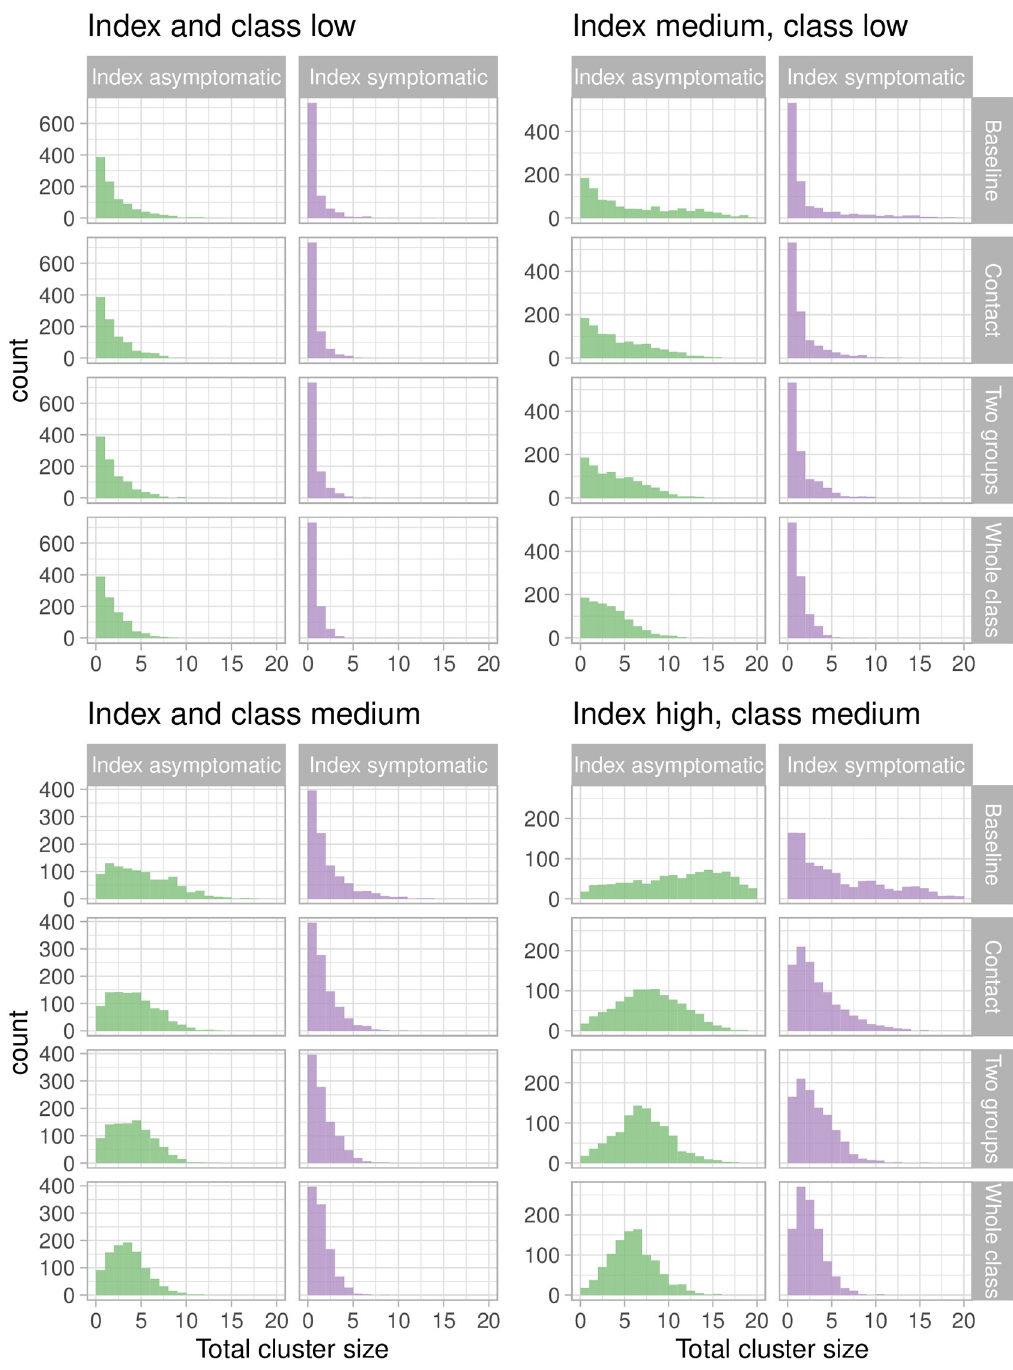
Fig 3. Otal cluster size. High variability in cluster sizes results from moderate variability in transmission. Cluster size distributions in 8 scenarios ranging from a low infectiousness index case in a low-transmission environment/activity (or class, top left) to an index case with 3 times the baseline transmission rate in an class with twice the baseline rate (bottom right). Left: the index case is asymptomatic. Right: the index case is symptomatic.